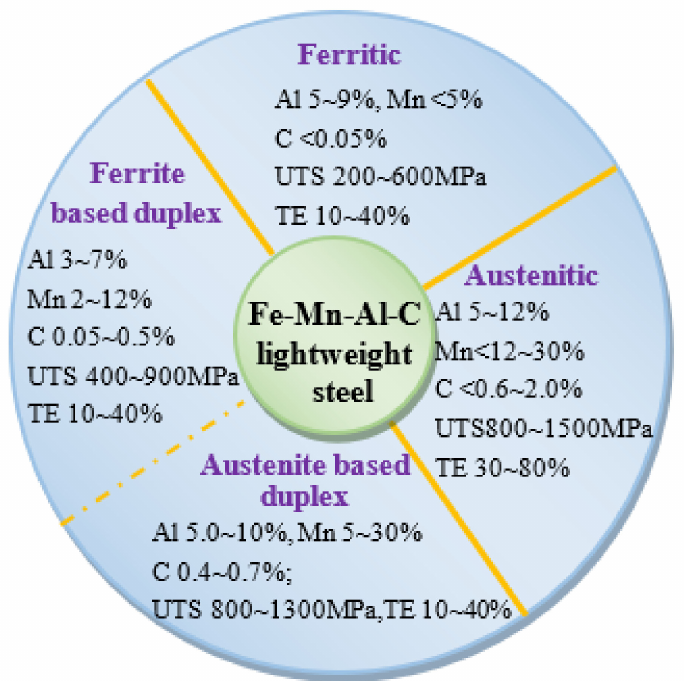
Figure 1. Classification of Fe-Mn-Al-C lightweight steels according to hot rolled microstructures, data from